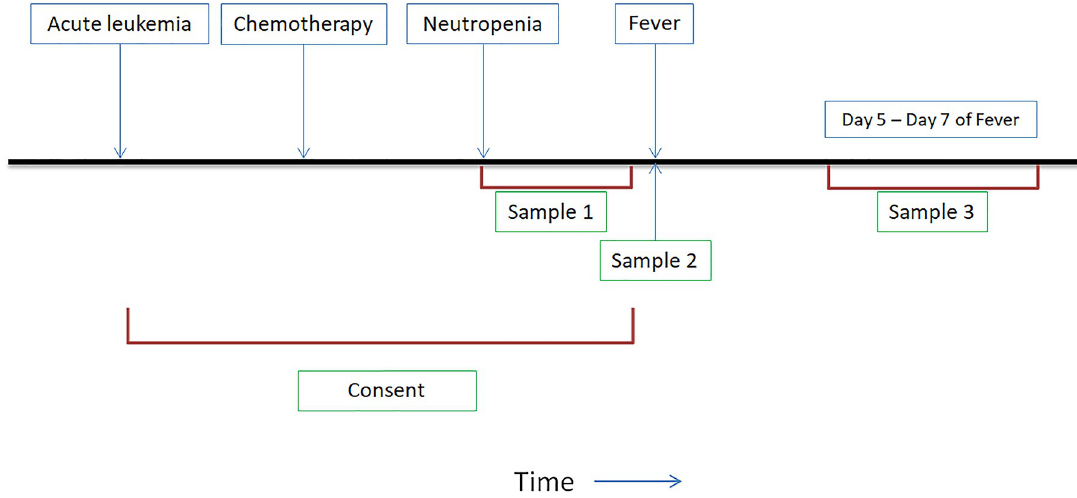
Fig 1. Timeline of blood sample collection for metagenomic shotgun